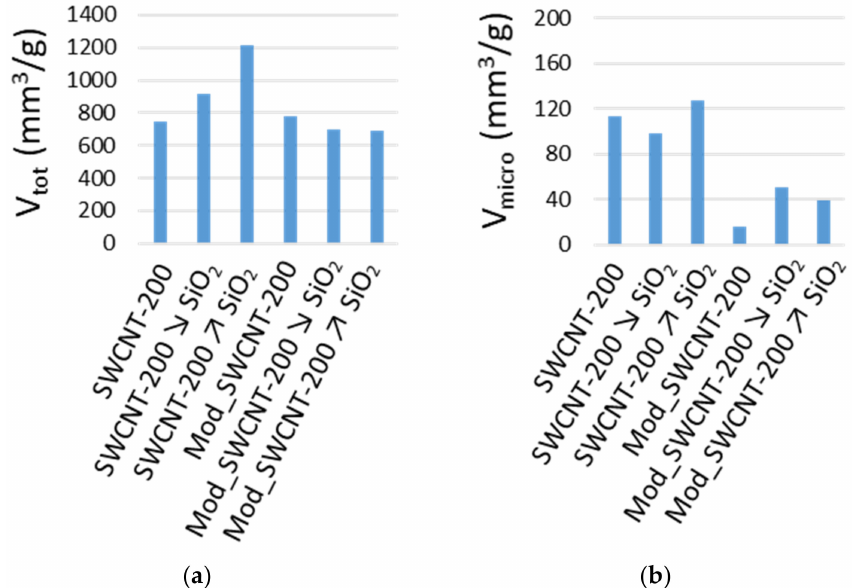
Figure 5. ( a ) Total pore volume; ( b ) micropore volume, determined from the N 2 adsorption isotherms. For the modified membranes, S BET decreases with increasing SiO 2 content (Table